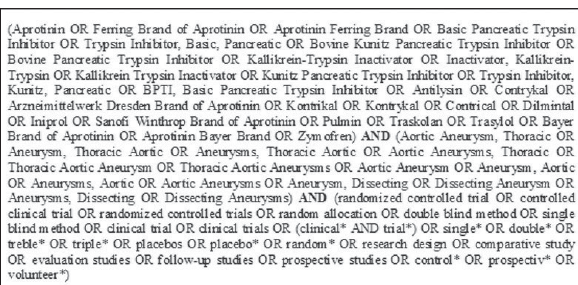
Fig. 1 - Estratégia de busca aplicada à base de dados da Medline®